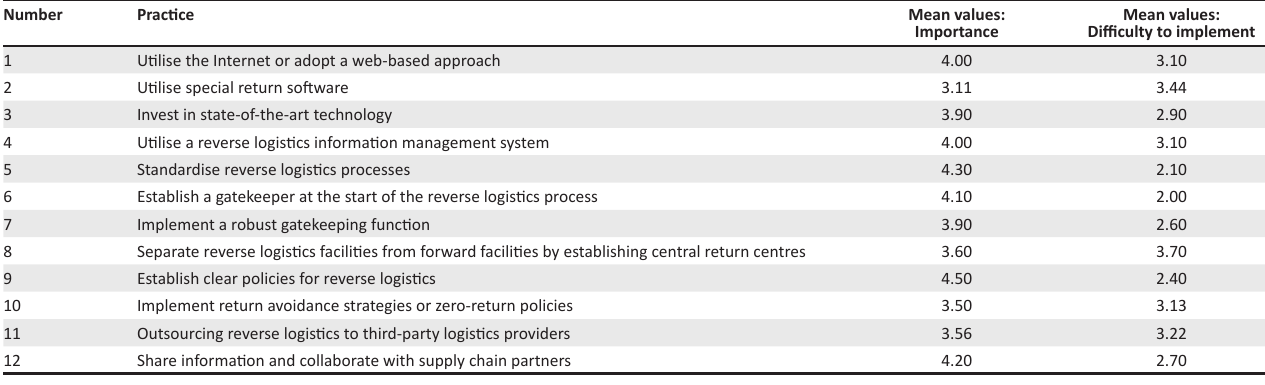
TABLE 2: Mean values of the importance and difficulty to implement practices to overcome operational barriers in reverse logistics. Number Practice